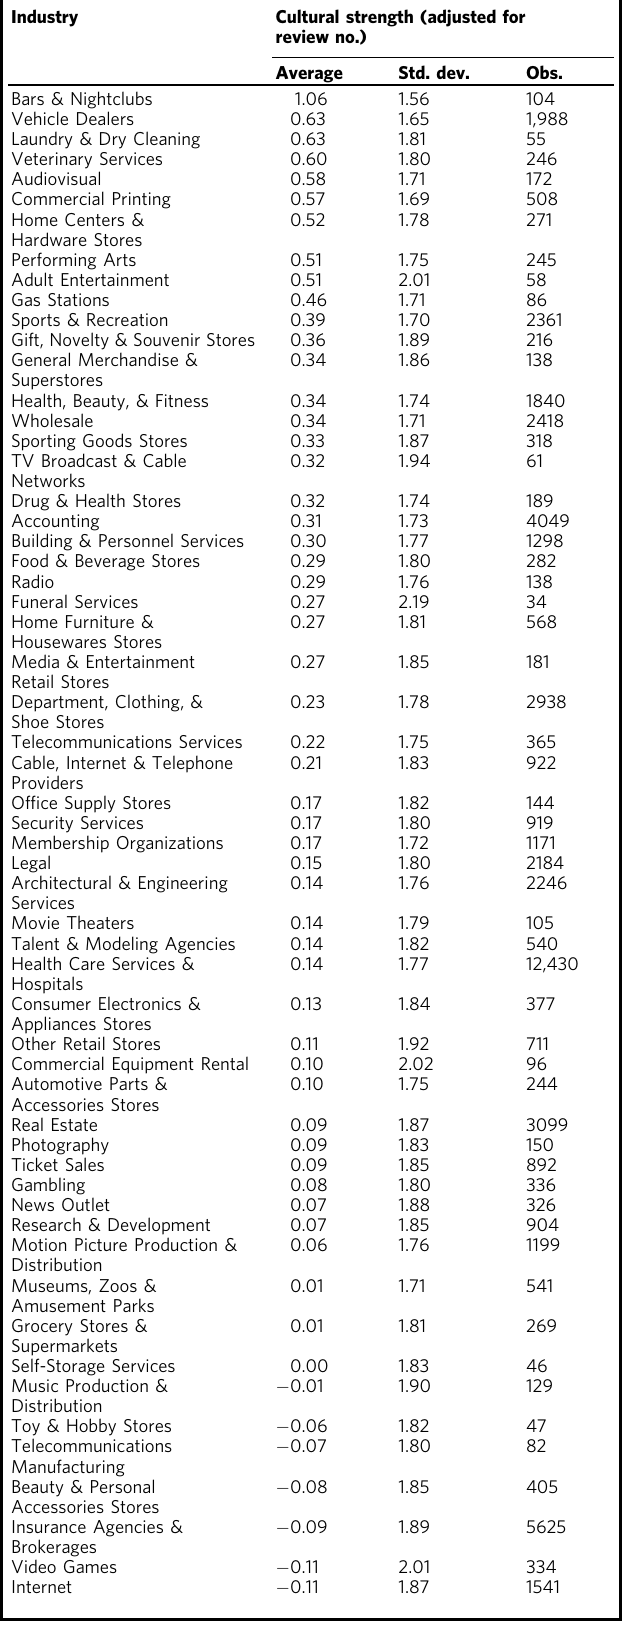
Table 4 Average cultural strength (computed on “ pros ” ) by